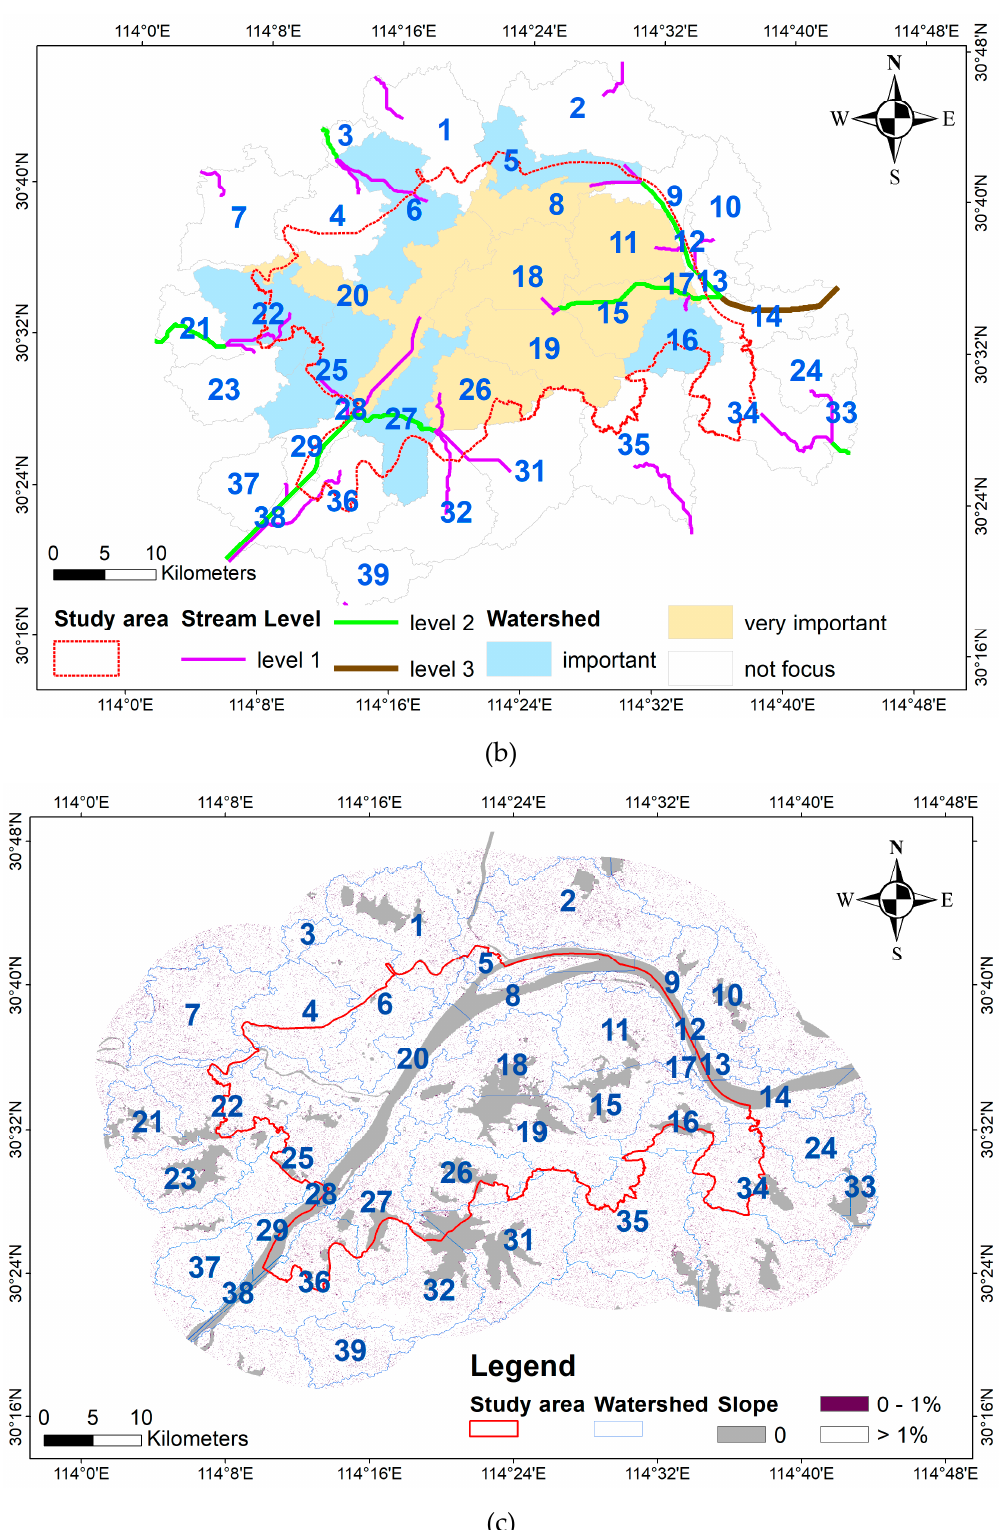
Figure 3. The basic maps for estimating urban flood-carrying capacity. ( a ) The land-use type related to the structure of the VIS-W model. The building for which the roof is plastic or brick is extracted independently. The runo ff coe ffi cient of the impervious surface is adopted to calculate the final rainwater. ( b ) The watershed delimitation derived by the DEM data set constrained by the water body. ( c ) The area with slope less than 1%. It is colored in two classes: slope = 0 and 0 < slope <